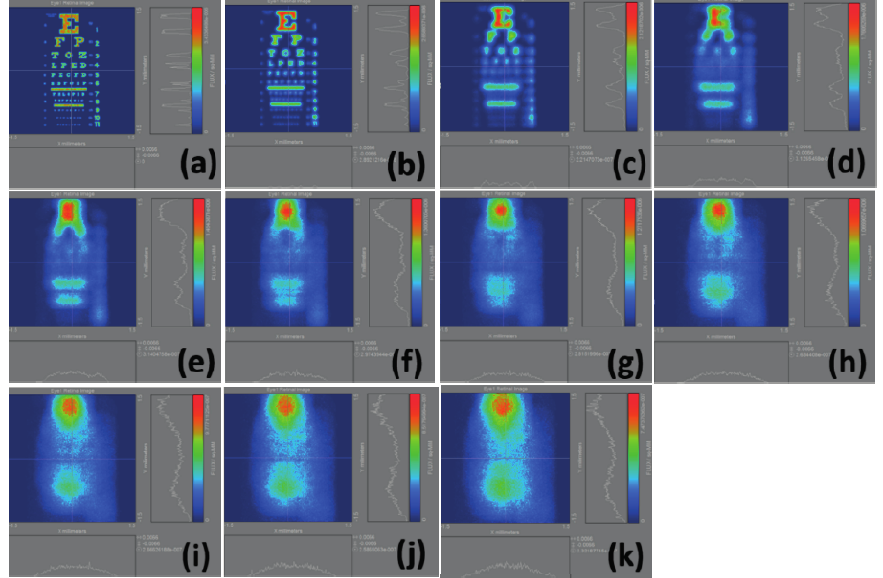
Figure 4. Calculation results of retinal images by selecting the whole Snellen chart in Figure 3(a); ( a ) plano; ( b ) 1.00 D; ( c ) 2.00 D; ( d ) 3.00 D; ( e ) 4.00 D; ( f ) 5.00 D; ( g ) 6.00 D; ( h ) 7.00 D; ( i ) 8.00 D; ( j ) 9.00 D; ( k ) 10.00 D.